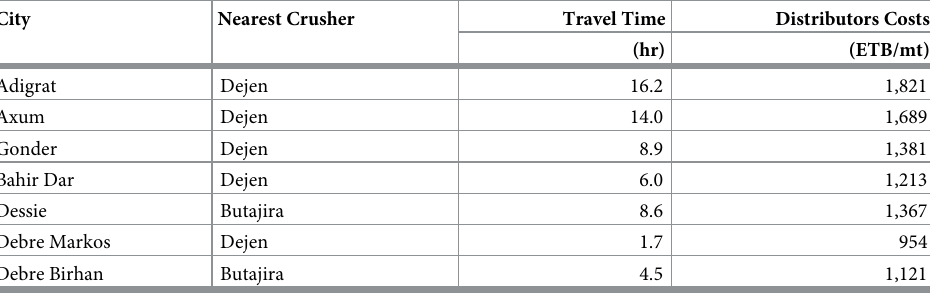
Table 2. Input distributors lime cost predictions for different